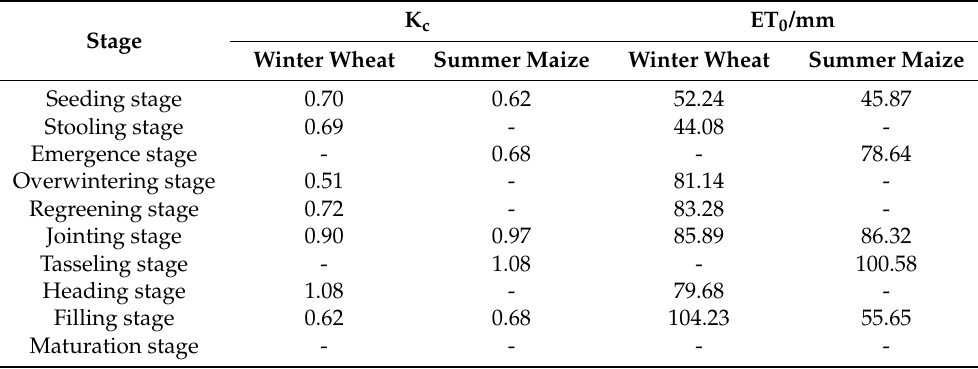
Table 2. Crop coefficients and reference crop evapotranspiration of winter wheat and summer maize at different growth stages.